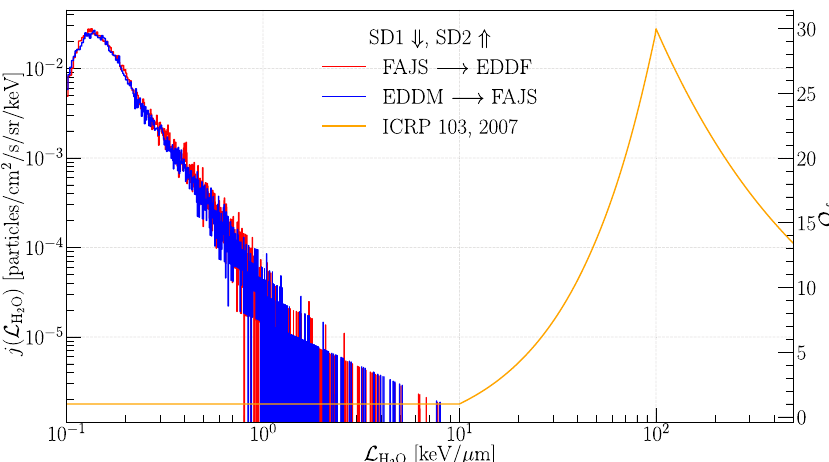
Figure 3. LET spectra accumulated for the fl ight to EDDF (in red) and a return fl ight to FAJS (in blue). The quality factor, as de fi ned by ICRP103 (2007), is shown in orange. Supplementary data are available on